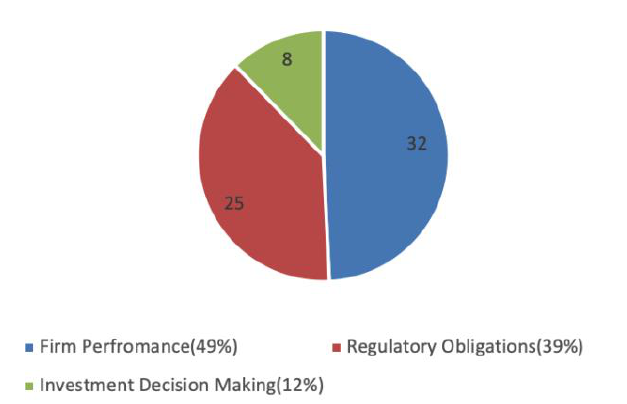
Figure 5: CG and ownership themes